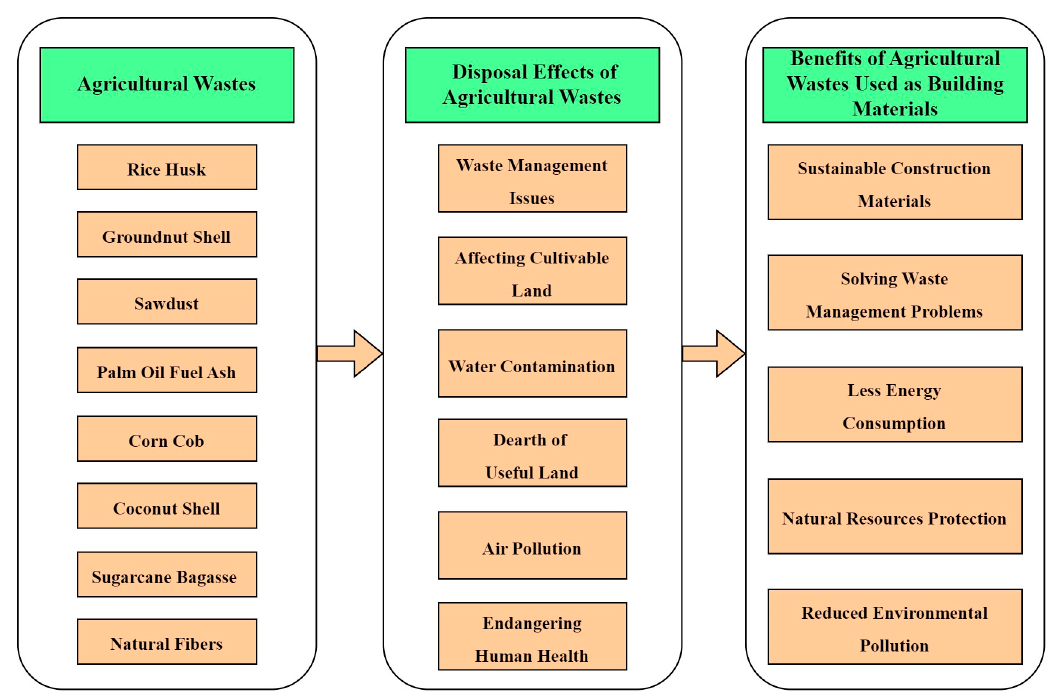
Figure 13. Flowchart showing generated agricultural wastes, their related disposal effects, and their benefits when used as building materials.